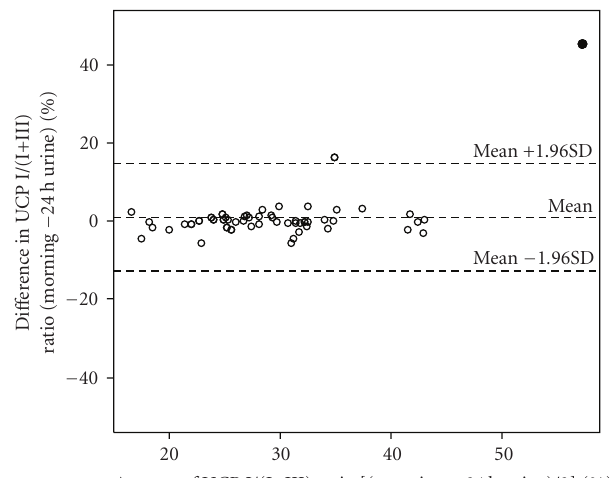
Figure 3: Mean UCP I/(I + III) ratio determined for morning and 24-hour urine samples (Bland and Altman plot). The black circle represents the subject with highly discordant UCP I/(I + III) ratio values between morning and 24-hour urine